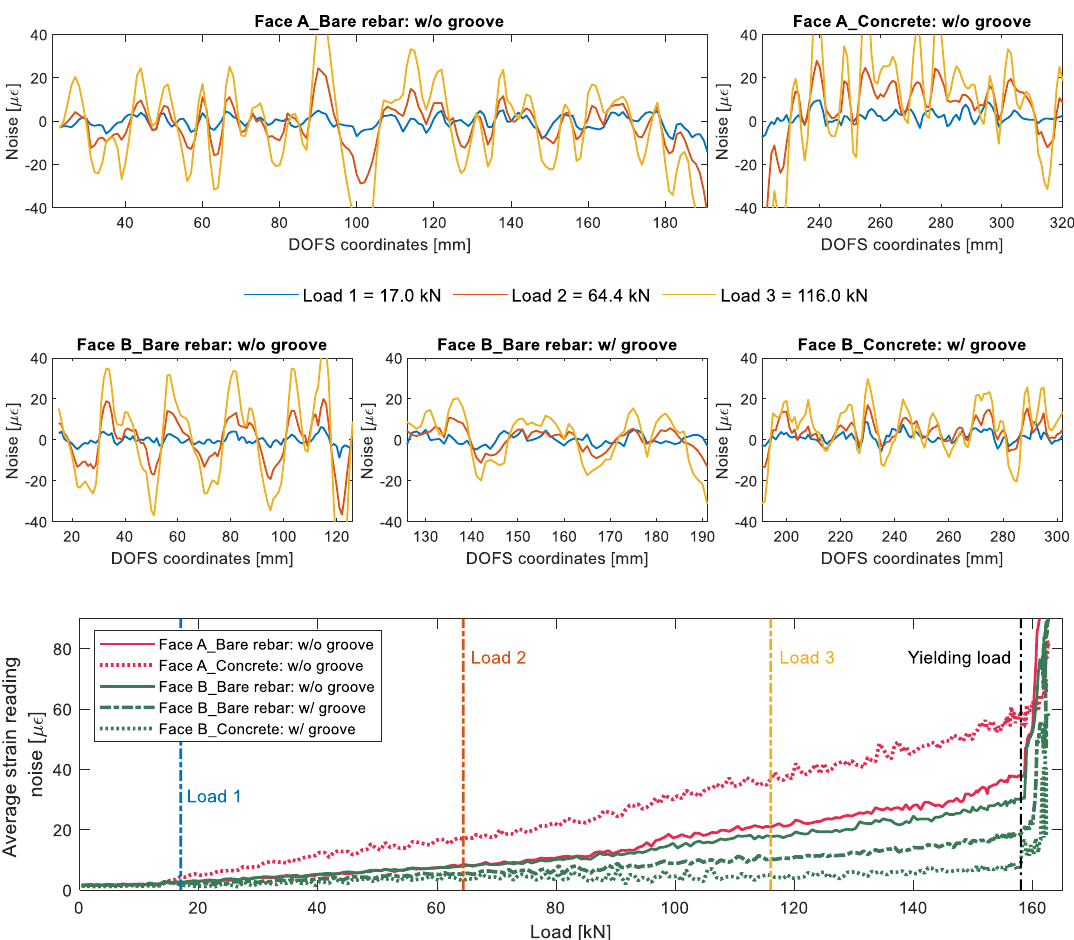
Figure 15. Rib-induced noise analysis of the outputs of member’s 15D20_24’s test (top five subplots) and of their relative average reading noises (bottom subplot).